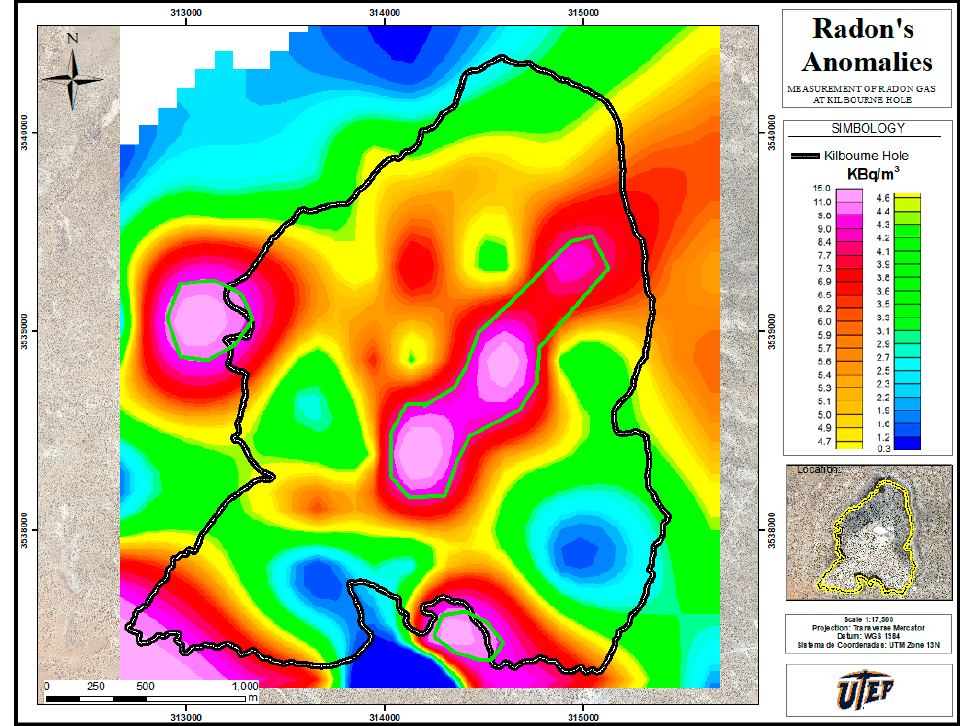
Figure 3. Heat map to evidence the C Rn gradient; radon anomaly corresponds to darker colors, which vary from 0.3 kBq/m 3 (blue) to 15.0 kBq/m 3 (pink); the green lines represent the radon’s anomalies.